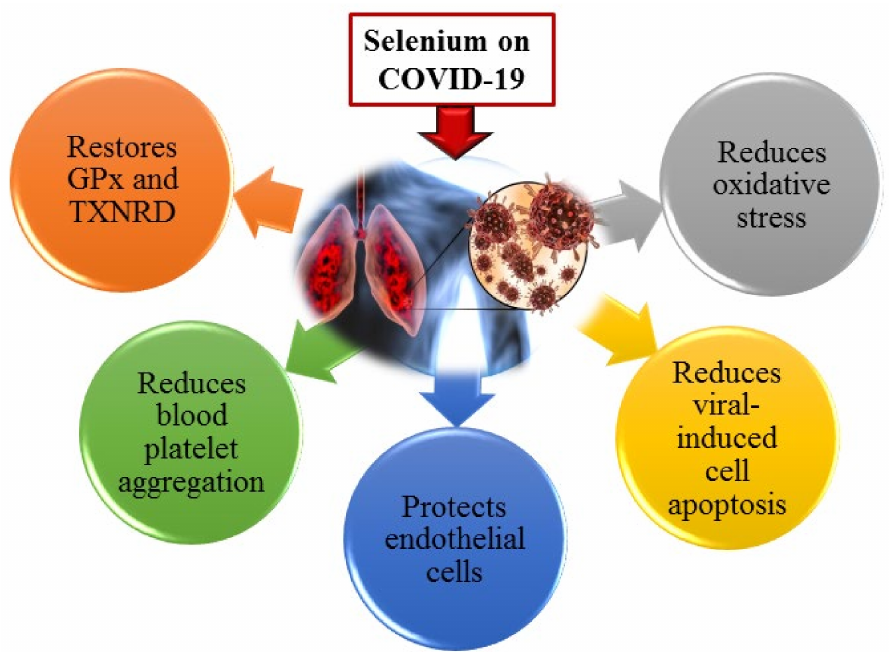
Figure 4. Effects of selenium supplementation on COVID-19. Adequate selenium levels reduce oxidative stress by restoring antioxidant enzymes, reduce cell death and coagulation pathways, and protect endothelial cells, thus having an overall protective effect on lungs and other